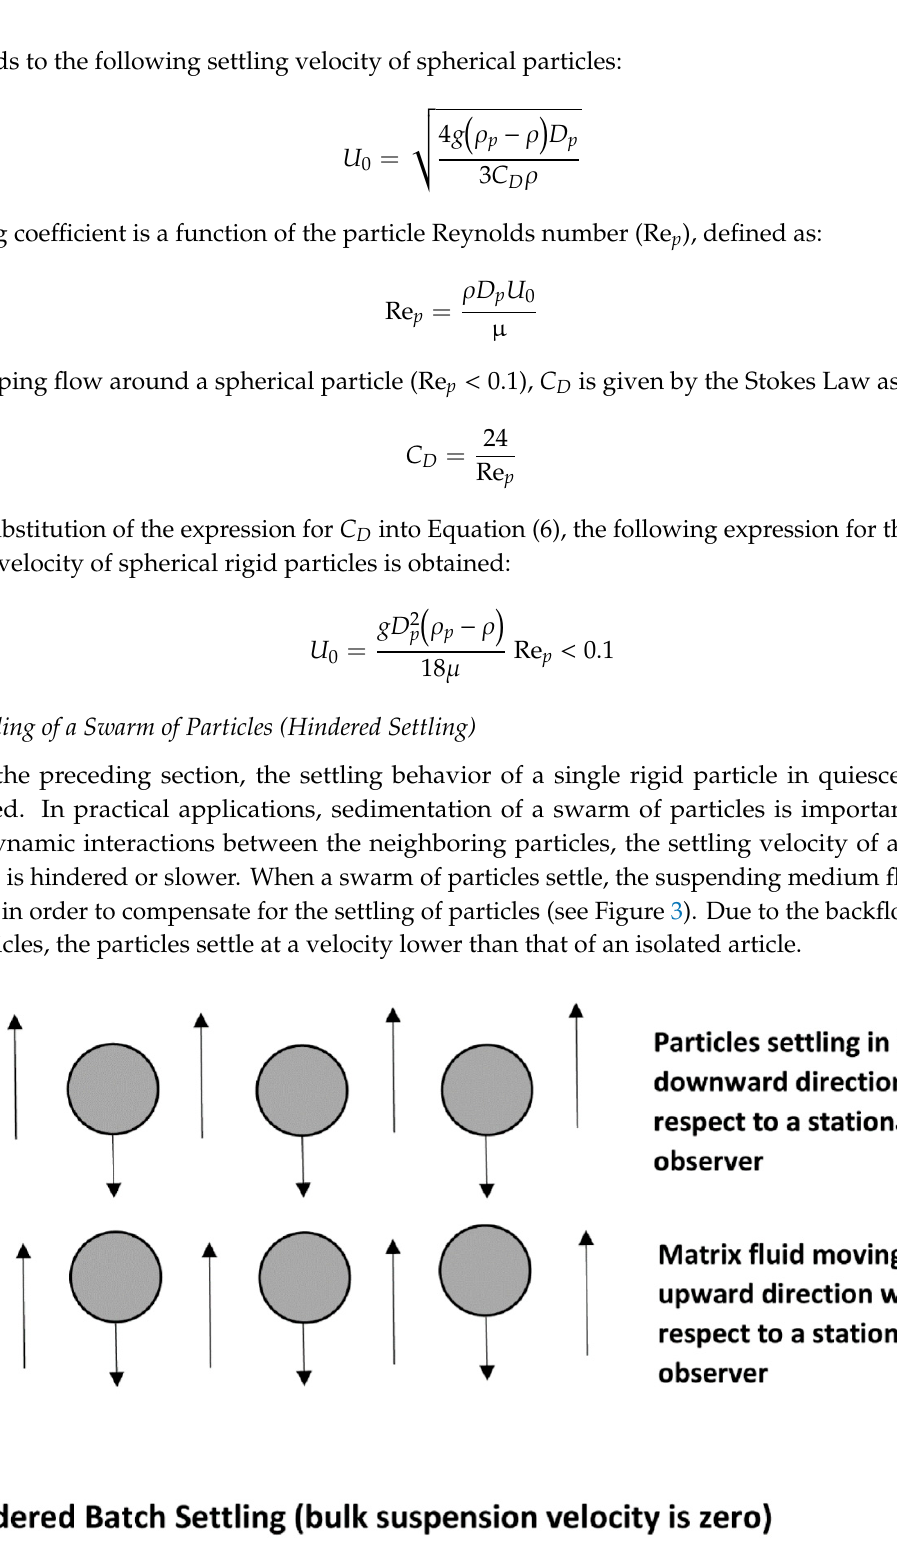
Figure 3. Hindered batch settling of particles.